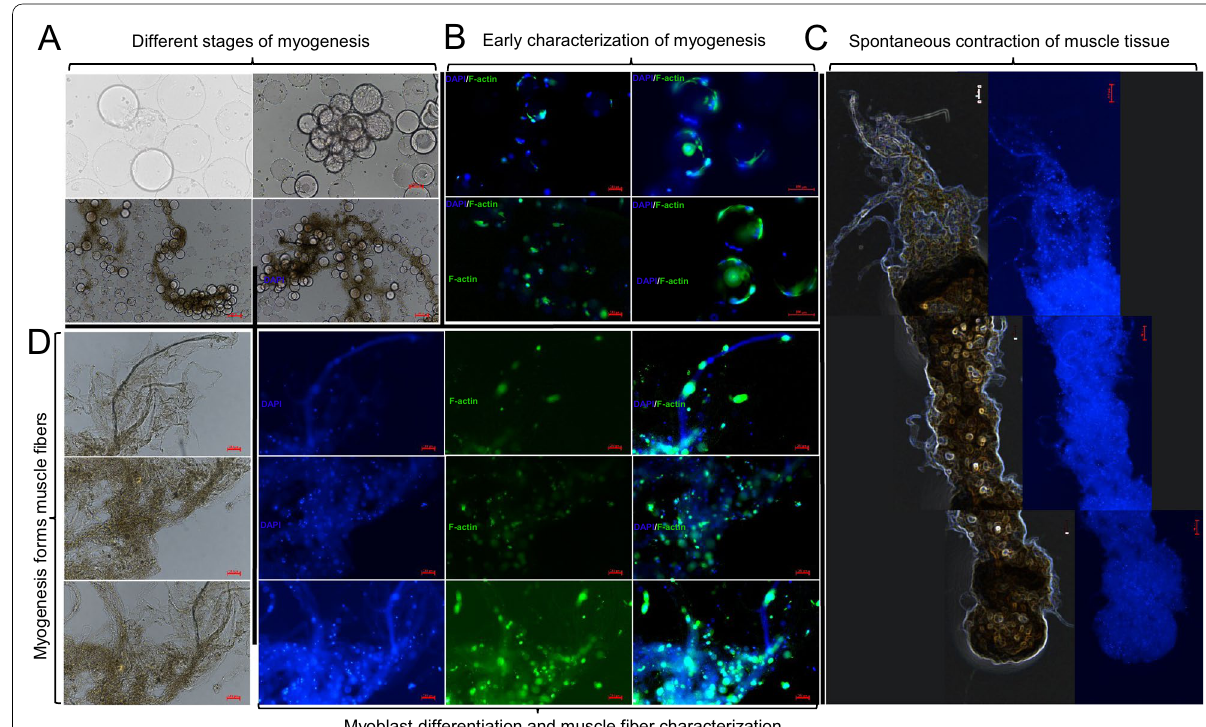
Fig. 4 Long resting time promotes cell myogenesis. A Diagram of myoblasts at different myogenesis stages. B Early myogenesis identification results. C Myogenesis forms muscle fibers and then a tissue-like structure that contracts spontaneously. D Myogenesis promotes the differentiation of myoblasts and the formation of tissue-like